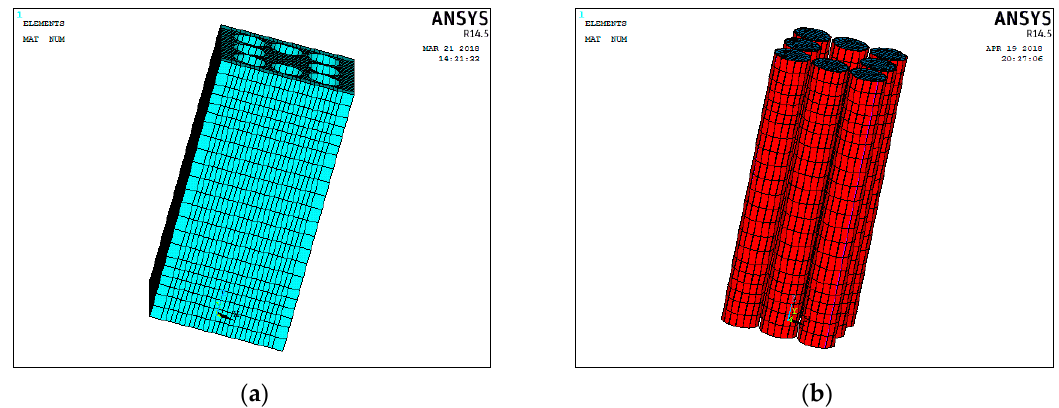
Figure 10. Finite element model of T8: ( a ) unconfined concrete and ( b ) fiber reinforced polymer confined concrete cores (FCCCs).